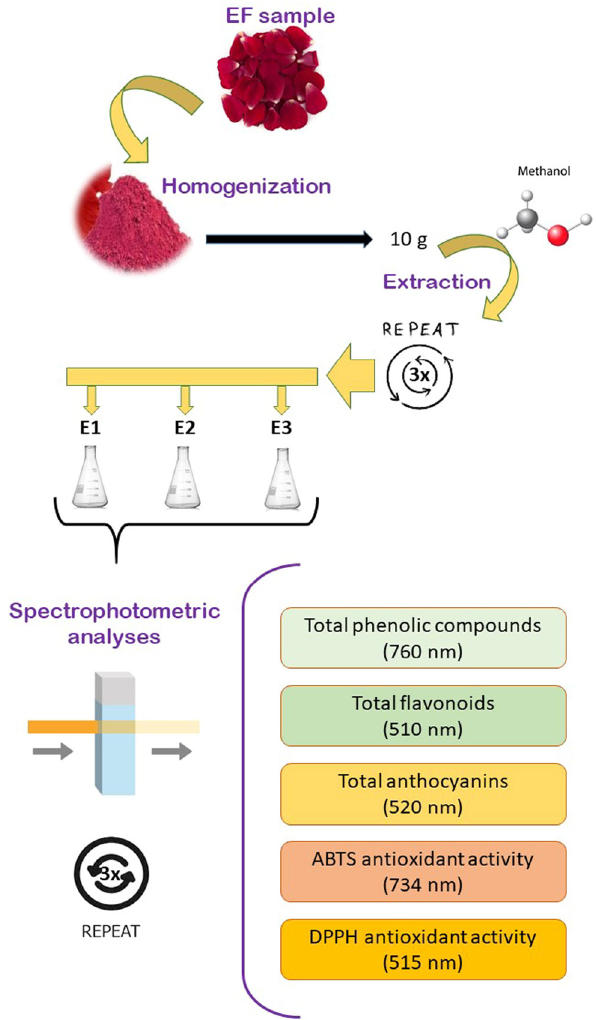
Figure 2: Schematic fl owchart of the experimental